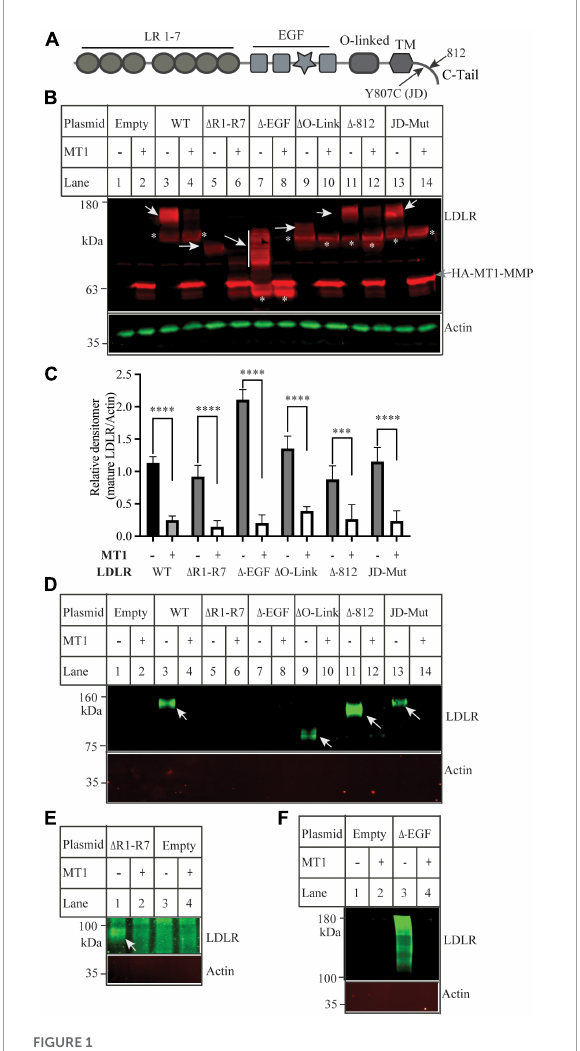
FIGURE1 Effects of mutations in low-density lipoprotein receptor (LDLR) on MT1-MMP-induced LDLR cleavage (A) Diagram of the functional domains of LDLR. LR, ligand binding region. EGF,